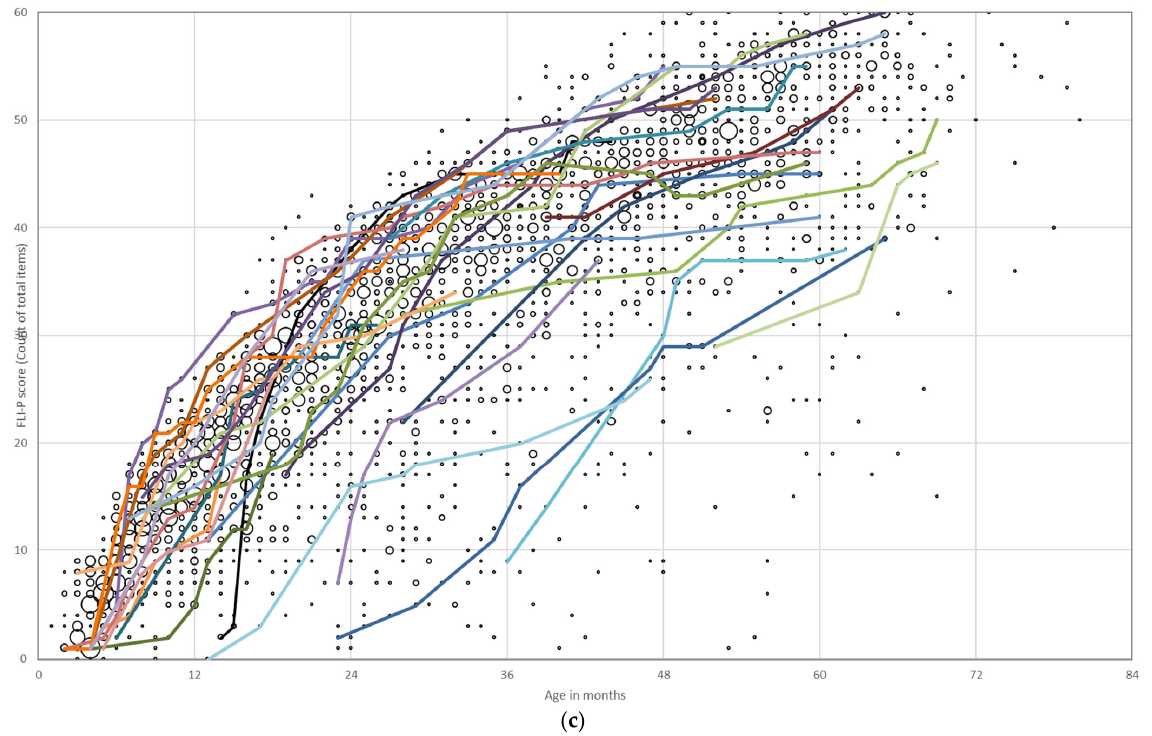
Figure 3. Individual listening trajectories of FLI-P scores of children with bilateral profound hearing loss who received their first cochlear implant ( a ) under 6 months of age; ( b ) between 6 and 11 months of age; and ( c ) between 12 and 23 months of age. Scores show a steep increase in skills post implantation and ongoing acquisition with age. Each of the colored lines represents an individual child’s trajectory to highlight progress and different listening development